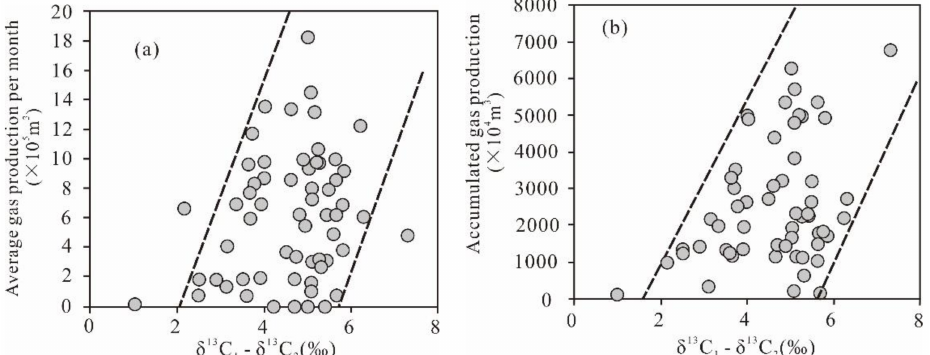
Figure 6. Relationship between δ 13 C 1 – δ 13 C 2 and the production of shale gas in Longmaxi Formation of Sichuan basin. ( a ) Relationship between the δ 13 C 1 – δ 13 C 2 and the average production per month of shale gas in Longmaxi Formation of Sichuan basin. ( b ) Relationship between the δ 13 C 1 – δ 13 C 2 and the accumulated production of shale gas in Longmaxi Formation of Sichuan basin.